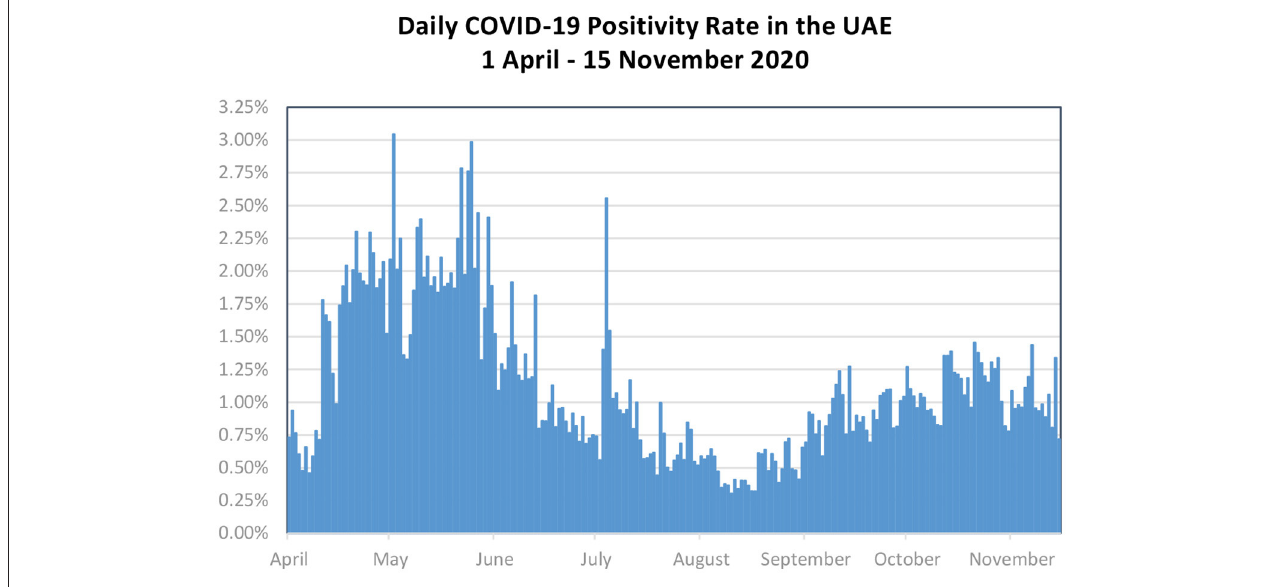
FIGURE 2 | Daily COVID-19 positivity rate in the UAE. Source: UAE Federal Competitiveness and Statistics Authority (FCSA).